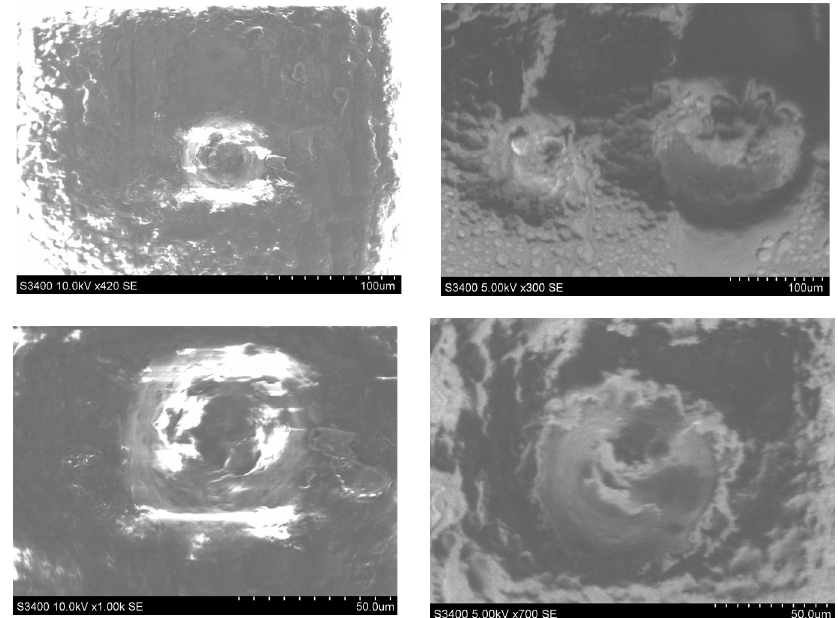
Figure 8. SEM microscopy analysis study in different four areas of the part.